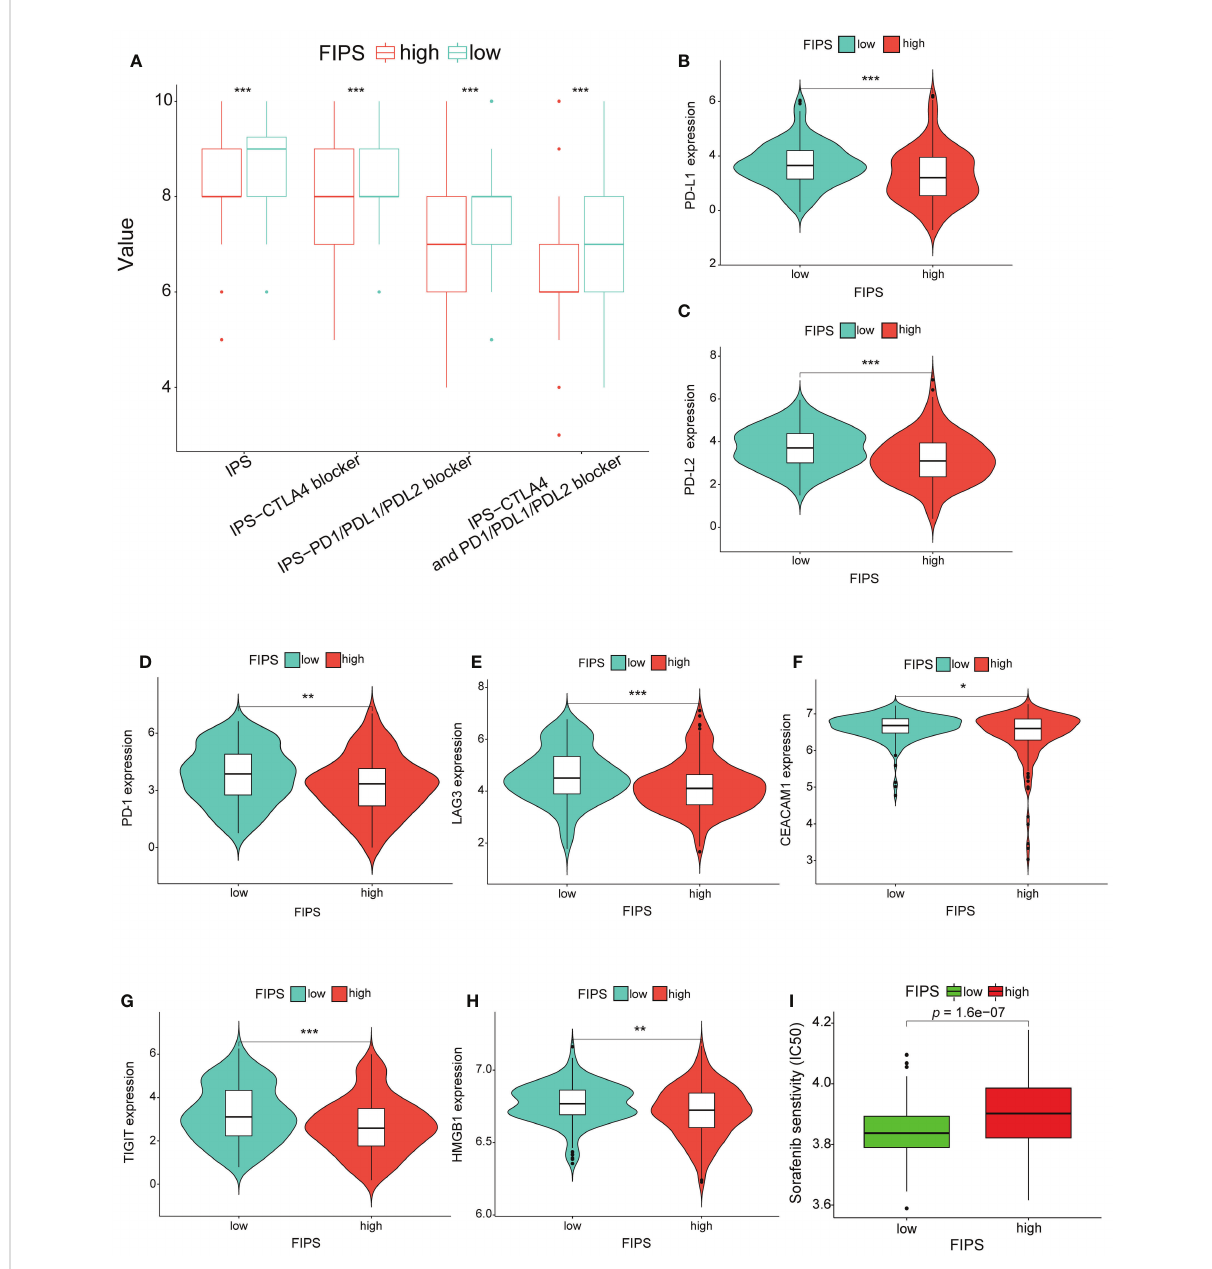
FIGURE 8 (A) Comparison between the immunophenoscore (IPS) value in the high- and low-FIPS subgroups in the TCGA cohort. (B-H) Comparison between the expression of several prominent immune checkpoints in the high- and low-FIPS subgroups of the TCGA cohort. (I) Comparison between the half maximal inhibitory concentration (IC 50 ) of sorafenib in the high- and low-FIPS subgroups of the TCGA cohort. * p < 0.05; ** p < 0.01; *** p < 0.001; **** p <